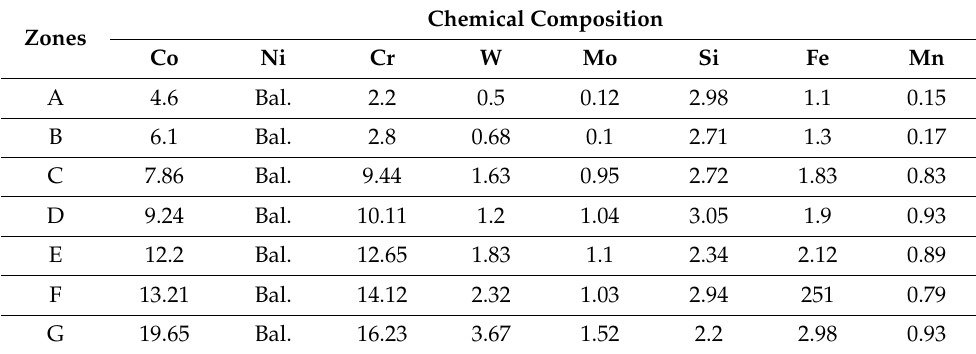
Figure 12. SEM micrographs of ( a ) fine M 23 C 6 carbide and ( b ) lamellar M 23 C 6 carbide and ( c , d ) EDX spectra of the corresponding phases. Table 4. EDX analysis of various phases indicated in Figure 13 (wt.%).